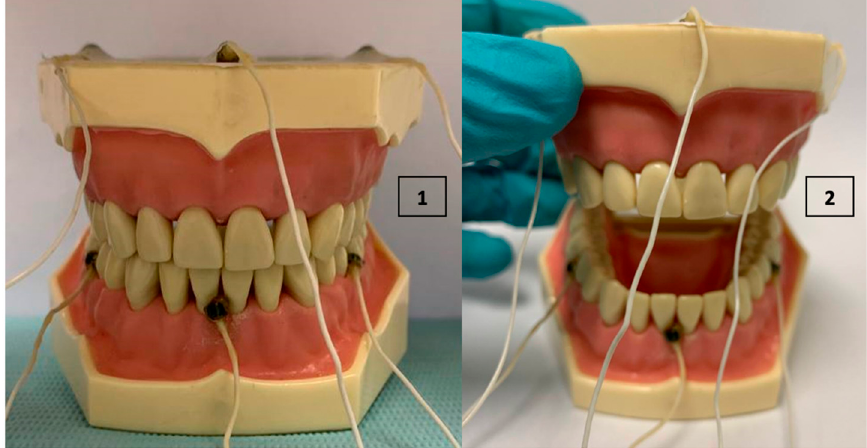
Figure 4. ( 1 ) Closed Phantom, MIP. ( 2 ) Manually open